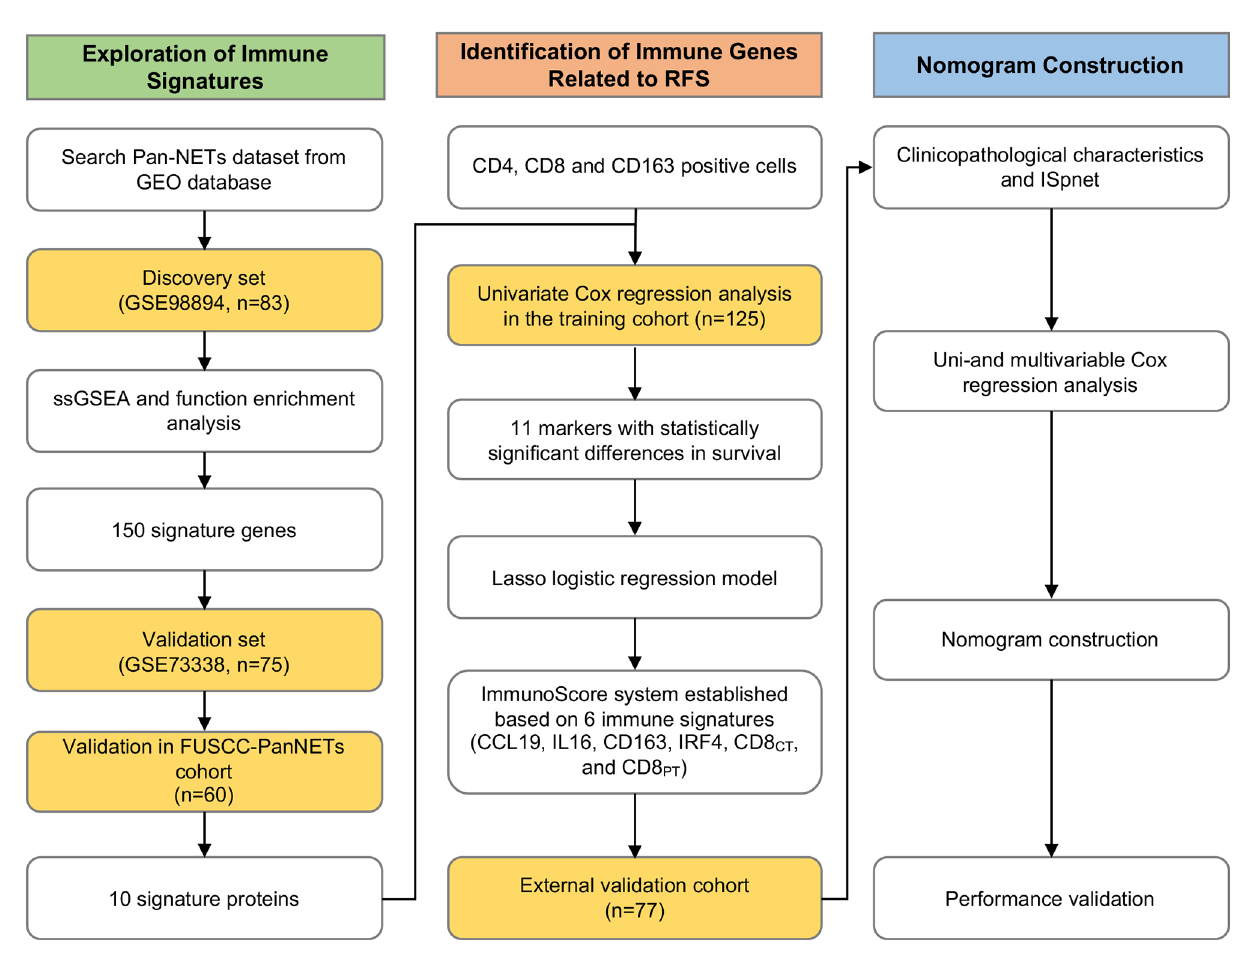
FIGURE 1 | Work fl ow of the present